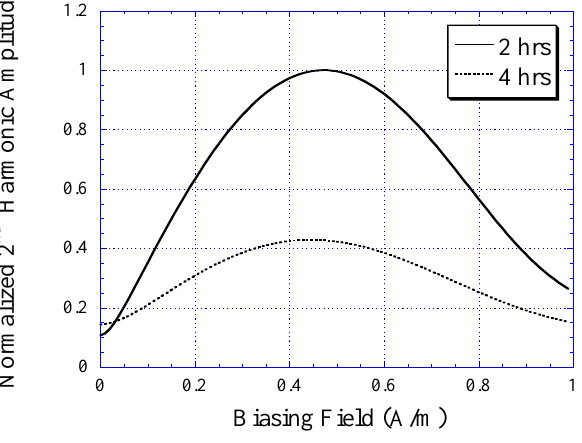
Figure 7. The 2nd-order harmonic fields of nickel-iron alloy samples (2 and 4 h plated) determined with the theoretical model.